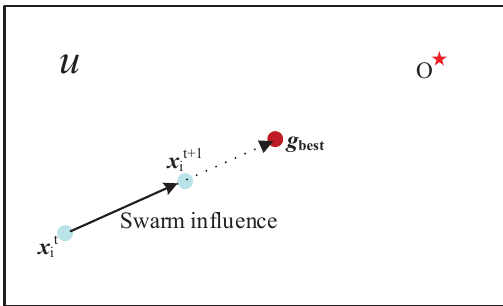
Figure 2. Optimization procedure of